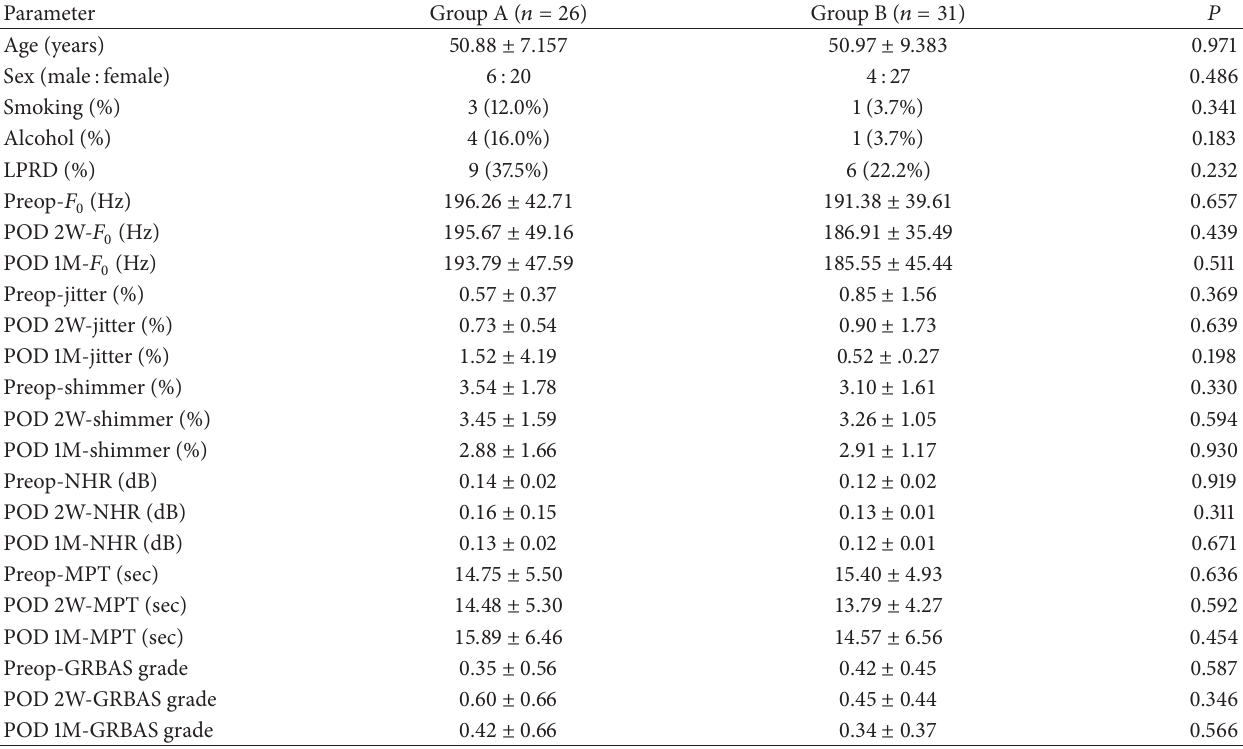
Table 1: Comparison of patient factors and acoustic and perceptual analyses of groups A and B.